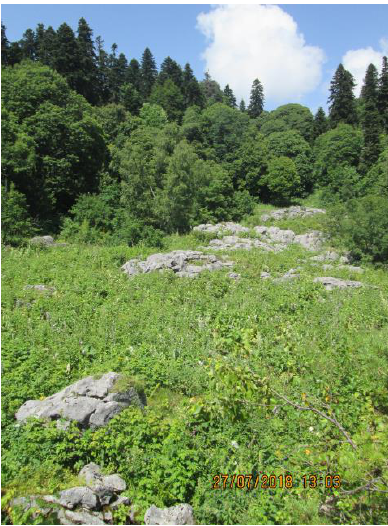
Figure 6. Megaclast formation as a result of carbonate karstification on the Lagonaki Highland in Russia (created by the author – D.A.R.). Table 2. A tentative genetic classification of megaclasts; the sign "+" marks correspondence of the categories.